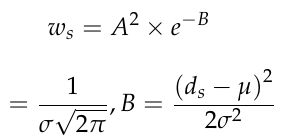
Figure 4. Spatial effect of neighbors.